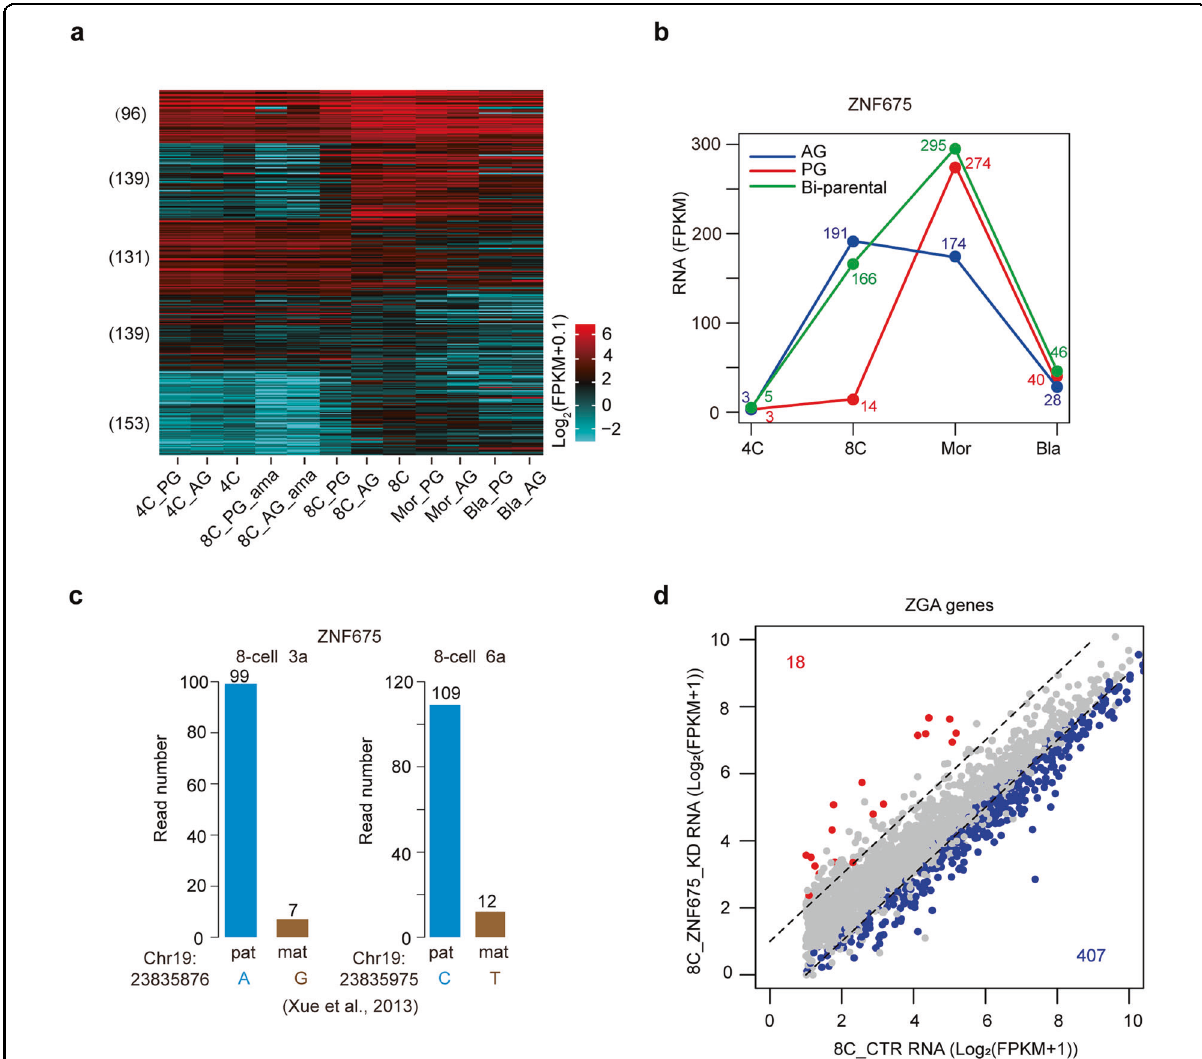
Fig. 2 Paternally expressed ZNF675 contributes to ZGA. a Heatmap showing the expression levels of transcription factors (TFs) in human haploid embryos, α -amanitin (ama) treated haploid embryos and bi-parental embryos. The TFs expressed at diploid 8-cell embryos are clustered by k-means method. b Plot showing the expression levels of ZNF675 in human haploid and bi-parental embryos. c Bar plot showing the read numbers for ZNF675 transcripts from paternal and maternal genomes in human bi-parental 8-cell embryos (samples 3a and 6a). The RNA-seq data are from 35 . The locations of SNPs, and the alleles at these SNP loci in maternal (mat) and paternal (pat) genomes are indicated. d Scatter plot showing the expression levels of ZGA genes between ZNF675 KD and control (CTR) 8-cell embryos. The genes upregulated in ZNF675 KD embryos are labeled in red, while the genes downregulated in ZNF675 KD embryos are labeled in blue. The numbers of ZGA genes belonging to DEGs are